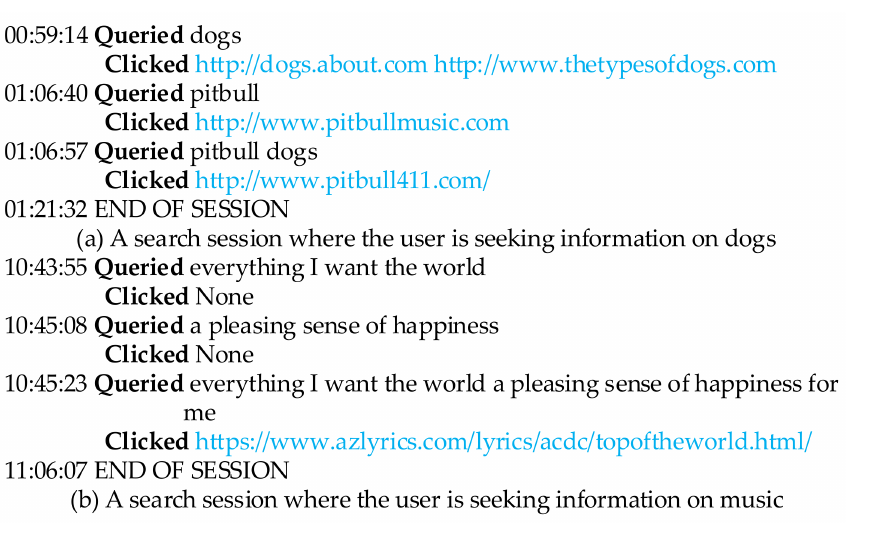
Figure 1. Examples of QCB